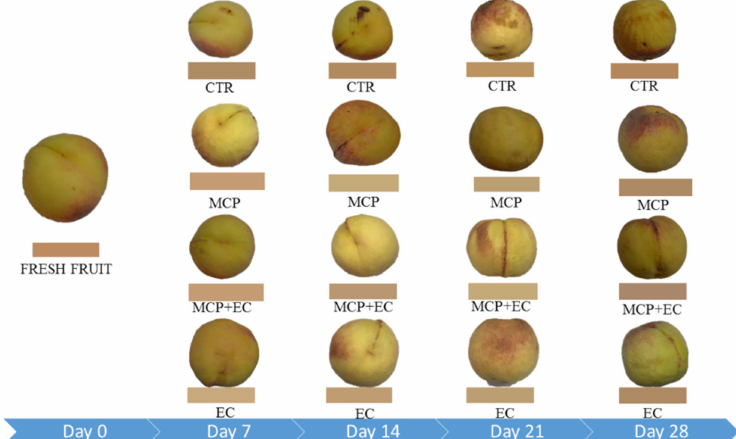
Figure 5. Conversion of the chromatic parameters L* a* b* in RGB using “e-paint.co.uk Convert Lab” software and subsequent comparison with photos of the examined fruits. n = 15 for each stage and treatment.